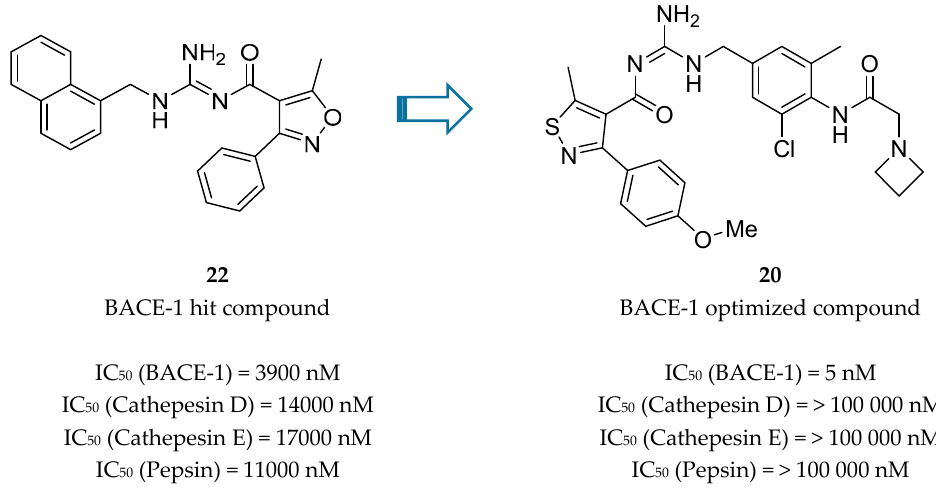
Figure 18. Acyl guanidine-based BACE-1 inhibitors developed by BMS [66].